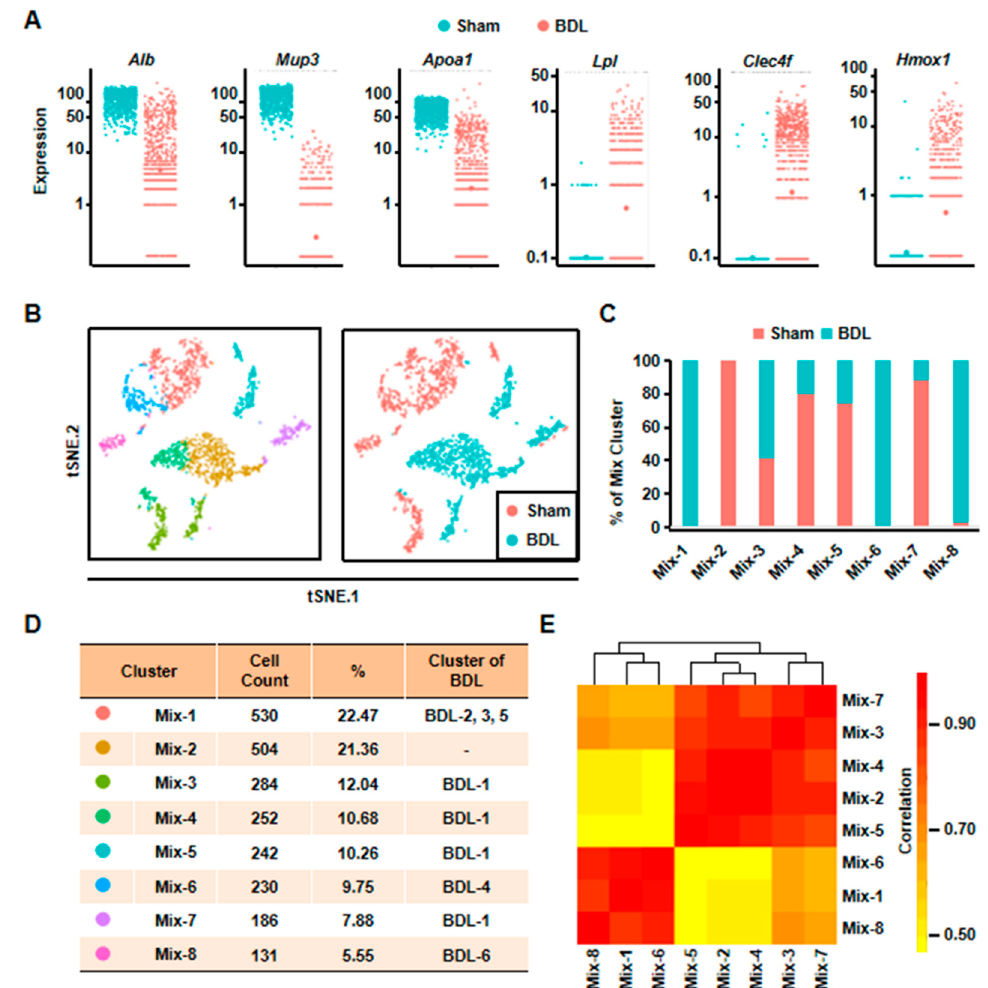
Figure 2. Eight clusters were classified of all the cells depending on scRNA-seq analysis. ( A ) The expressions of representative genes in normal and cholestatic hepatocytes were shown. ( B ) 2D visualization of single-cell clustering of hepatocytes profiles inferred from RNA-seq data in the mixed cells. Eight major classes of hepatocytes in normal and injured liver were detected. Colored bar coded as indicated in Figure 2D. ( C ) The components of each mix clusters. ( D ) The count of each cell population was indicated. Colored bar coded as indicated. ( E ) Correlation analysis of eight clusters.